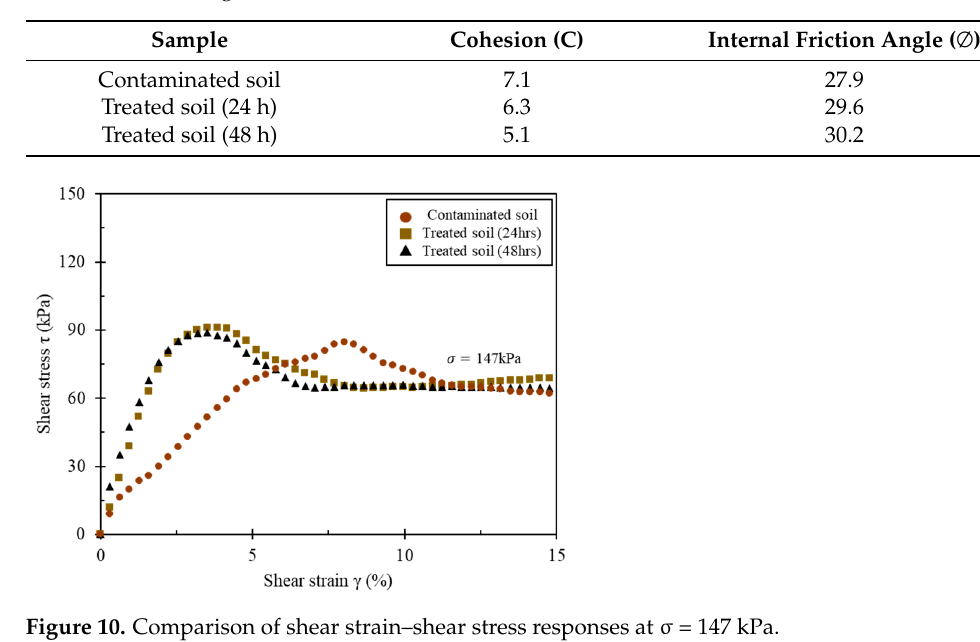
Figure 9. Shear strain–shear stress responses and Mohr–Coulomb failure envelope: ( a ) Contami- nated soil; ( b ) treated soil (24 h); ( c ) treated soil (48 h).